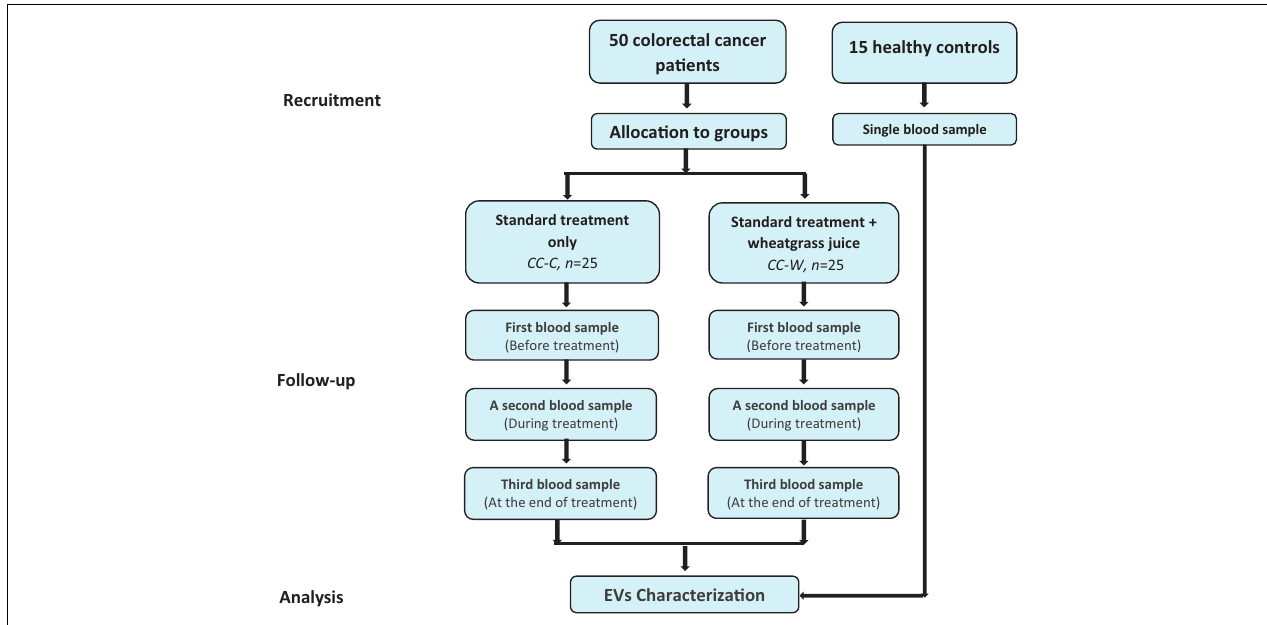
FIGURE 1 | Study design flow chart. Patients diagnosed with colon cancer at stages II–III toward adjuvant chemotherapy following curative surgery. Patients who were interested in participating were admitted to the WGJ (CC-W) group. Blood samples were collected from CC-W and from non-WGJ patients, following consent. Blood samples were obtained at three time points: before first chemotherapy (time point I – BT), after 3 months of chemotherapy (time point 2), and at the end of chemotherapy administration (time point 3). One blood sample was collected from each healthy control (HC). PPP EVs were analyzed.